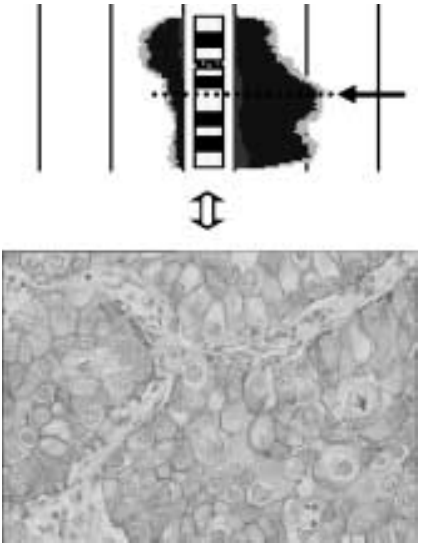
Fig. 4. The overexpression of HER2/NEU being located at chromo- some 17q21 correlates with DNA gains of the respective chromoso- mal band in